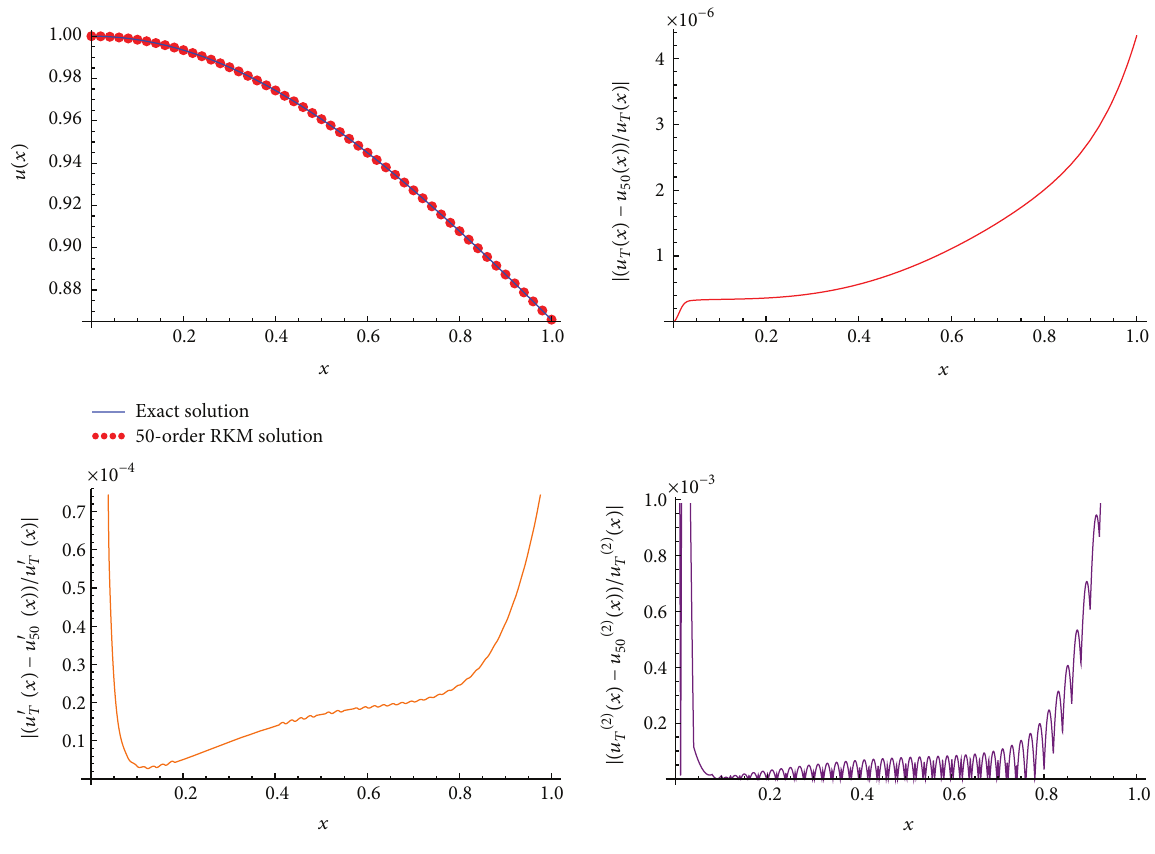
Figure 1: Present numerical method for Example